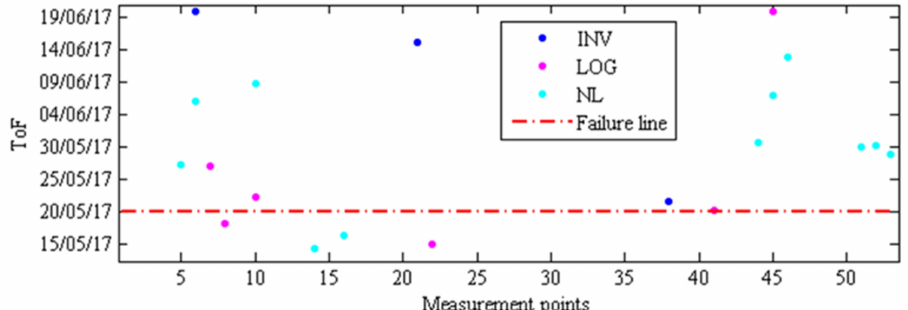
Figure 12. Prediction graph representing the failure forecasting methods applied on the time series of displacement characterized by a trend change between 25 October 2016 and 25 January 2017 (pick 3). The computed Time of Failure (ToF) is reported on the y-axis and the measurement points on the x-axis. The failure line represents the actual time of the slope